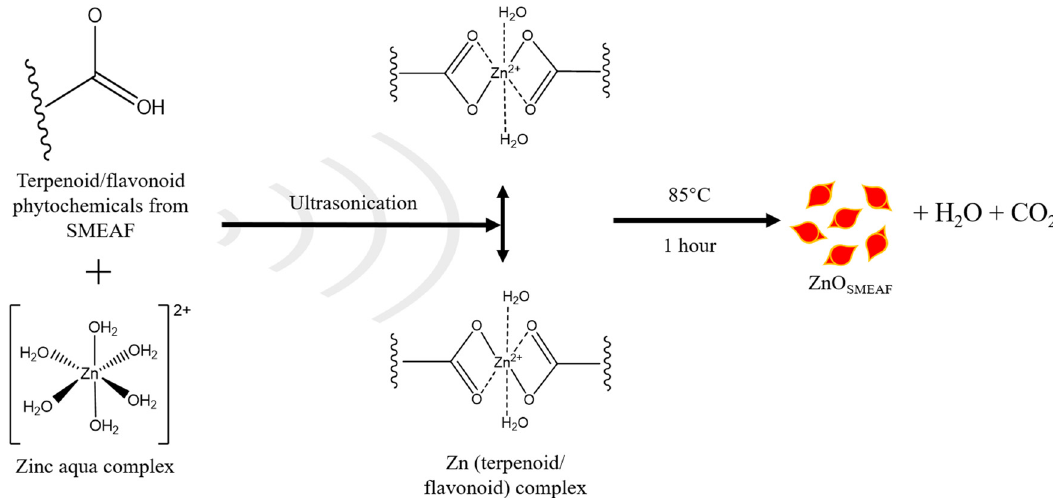
Figure 6: Proposed mechanism for the ultrasonic - aided synthesis of ZnO SMEAF